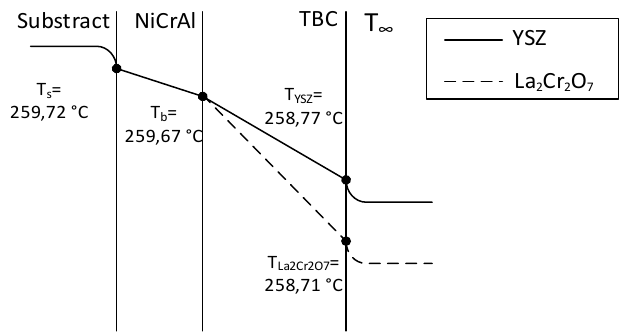
Figure 10. Surface temperature of coated AHB.